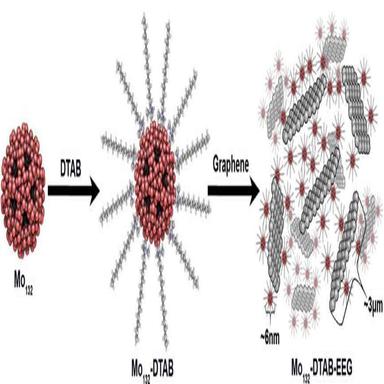
Schematic representation of the formation of Mo132-DTAB-EEG hybrid material.